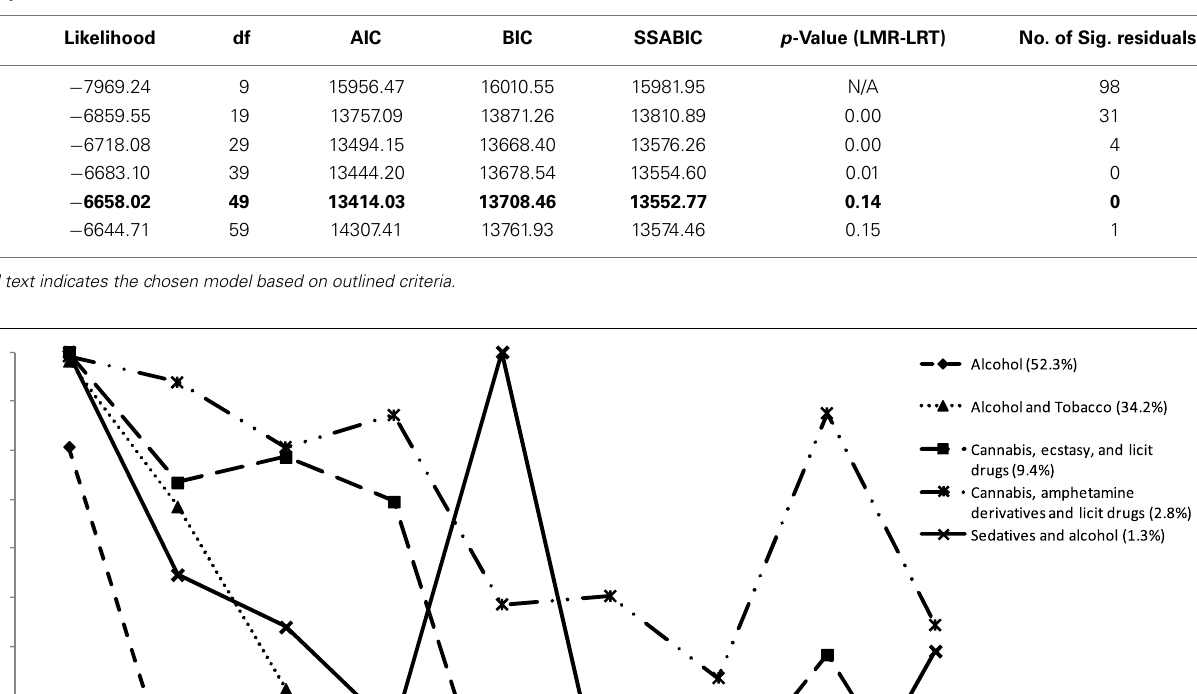
Table 1 | Fit statistics from 1 to 6-class models .